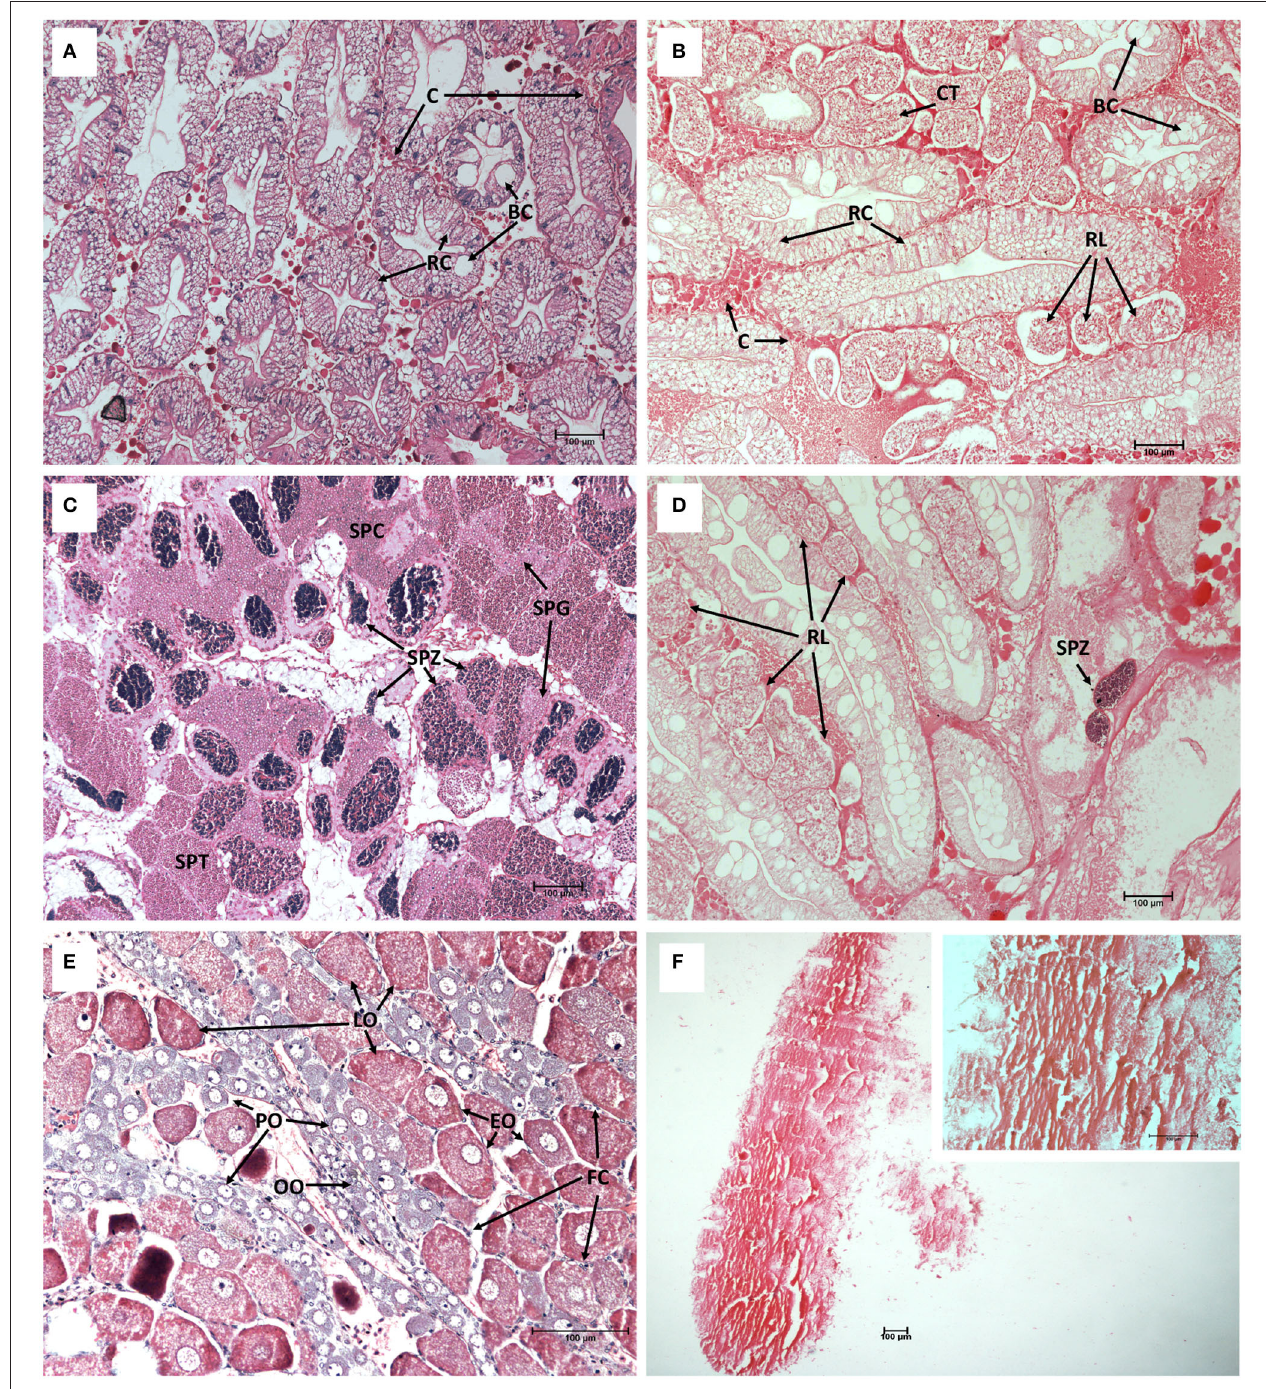
FIGURE 2 | The hepatopancreas and gonad histological cross-sections of healthy (A,C,E) and infected Scylla olivacea (B,D,F) (Mayer’s Hematoxylin-Eosin staining). (A) Healthy hepatopancreas with normal tubule shape and arrangement, magnification 10 × ; (B) Infected hepatopancreas with the presence of rhizocephalan rootlets (RL) and collapsed tubules (CT), magnification 10 × ; (C) Healthy testis with the presence of spermatogonia (SPG), spermatocytes (SPC), spermatids (SPT) and spermatozoa (SPZ), magnification 10 × ; (D) Infected testis with the presence of RL, almost no spermatogenesis activity, cell lysis and only remnants of SPZ could be found, magnification 10 × ; (E) Healthy ovary with the presence of oogonia (OO), primary oocytes (PO), early-maturing oocytes (EO) and late-maturing oocytes (LO), with follicle cells (FC) surrounding oocytes, magnification 20 × ; (F) Infected ovary appeared degenerated and no rigid cell structures were observed, magnification 4 × (large panel) and 20 × (upper right panel). Connective tissues (C), R-cells (RC), B-cells (BC).